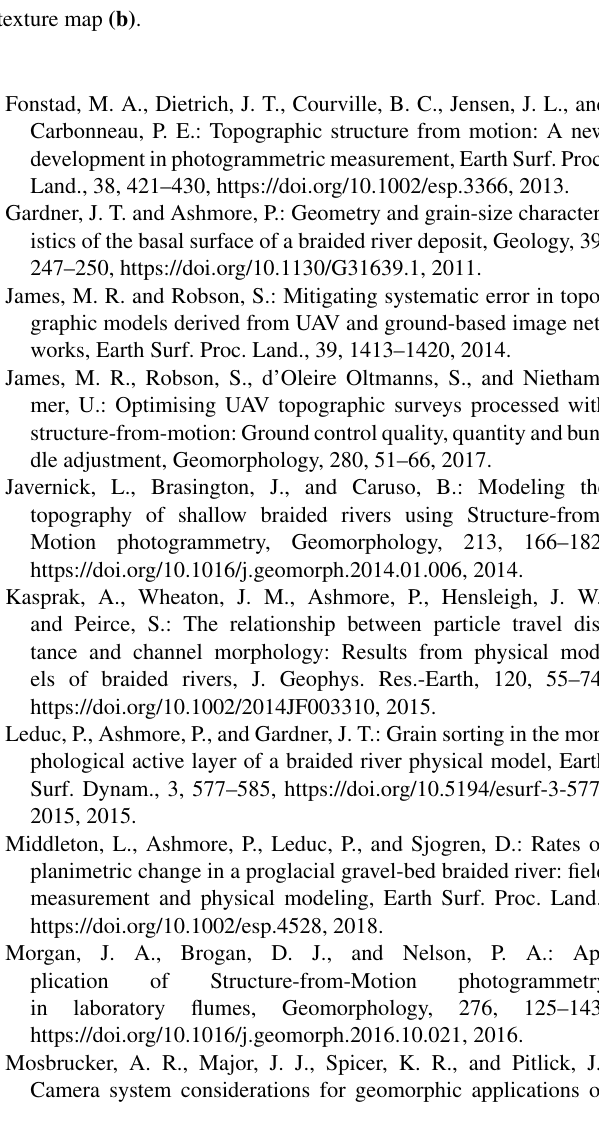
Figure 12. An example DEM (a) plotted with its associated equivalent texture map (b) .